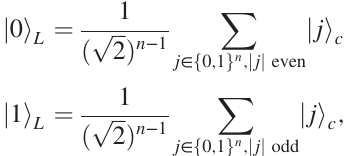
FIG. 3. Overall scheme for achieving fault-tolerant universal quantum computation using cat qubits. The fundamental operations (left- hand side) are performed on the cat qubits, in a bias-preserving manner. Fault-tolerant logical operations acting on the repetition cat qubits (right-hand side) are built out of these operations, as depicted by the arrows. This construction is detailed in Sec.